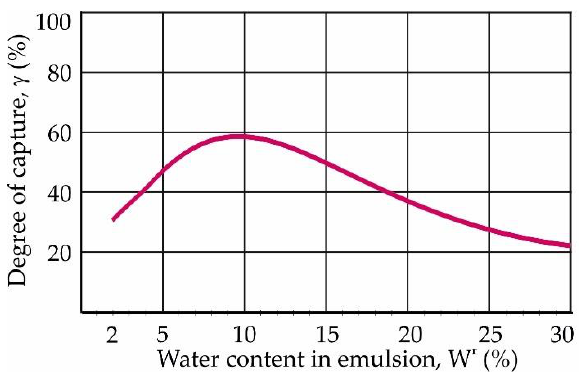
Figure 13. Dependence of the “ degree of capture ” of PM by condensing LTHS.